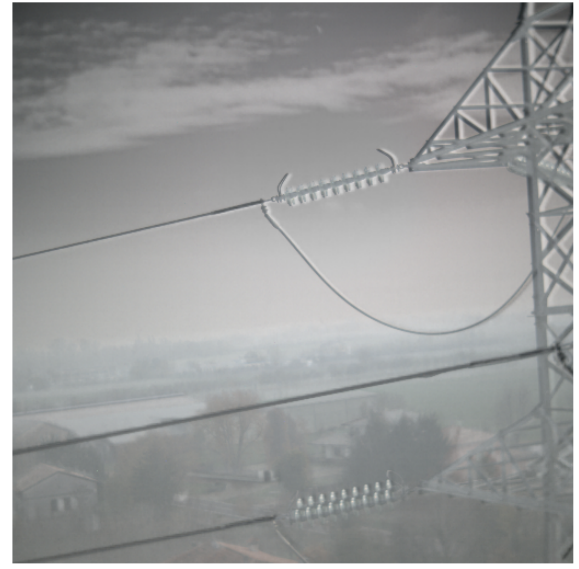
Figure 7. Overlapping of fixed (visible) and moving (IR) images with same size after